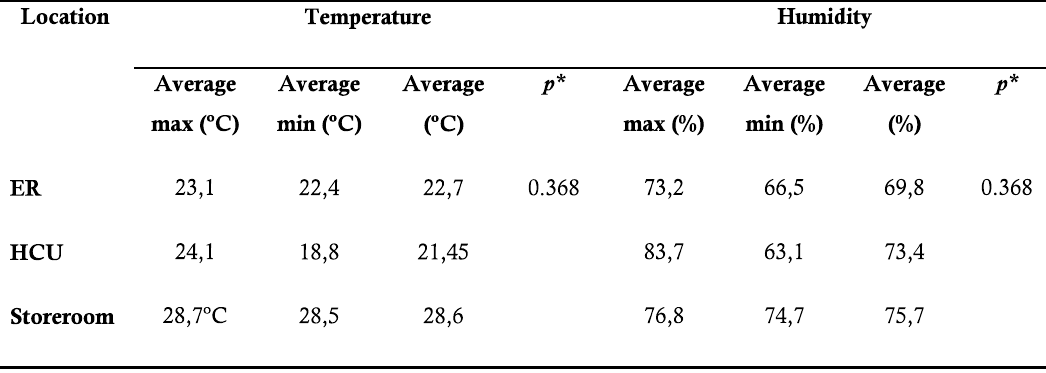
Table 4. Average Temperature and Humidity for 10